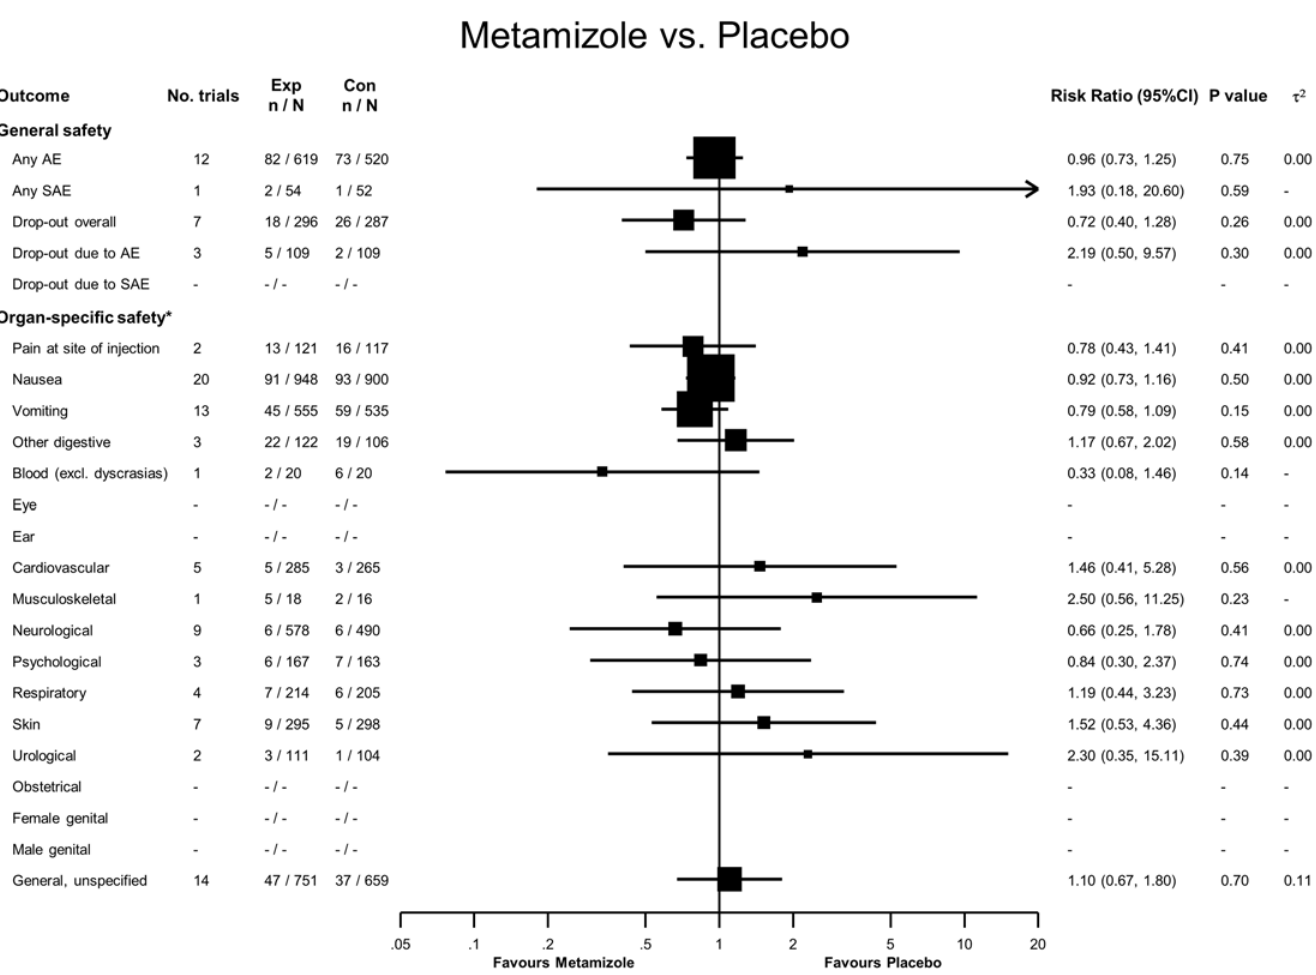
PLOS ONE | DOI:10.1371/journal.pone.0122918 April 13,